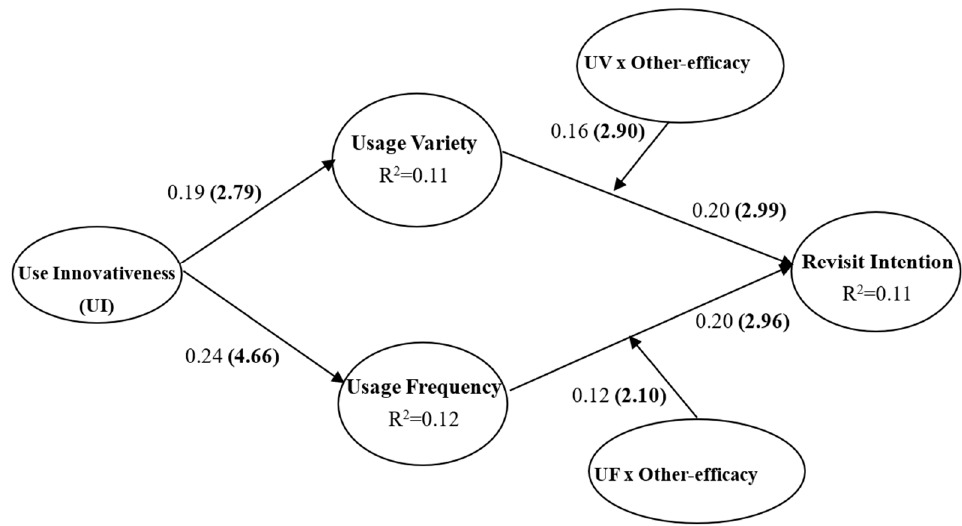
Figure 1. Path coefficients. The numbers in parentheses are t -values.